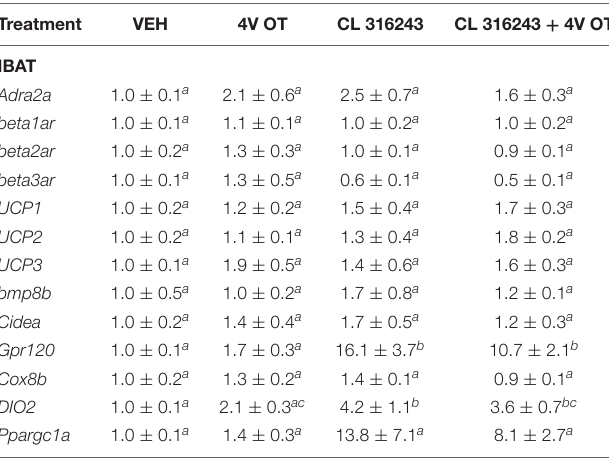
TABLE 3 | Changes in IBAT gene expression following chronic 4V OT (16 nmol/day) and systemic CL 316243 (0.5 mg/kg) treatment in male DIO rats. Treatment VEH 4V OT CL 316243 CL 316243 + 4V